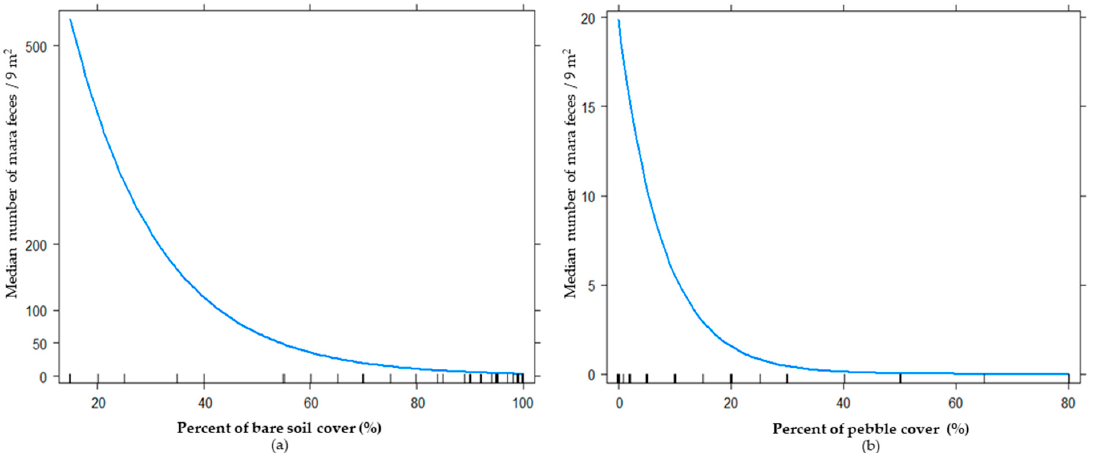
Figure 3. Relationship between habitat use of maras ( Dolichotis patagonum ) measured as median number of mara feces by quadrat (3 m × 3 m) and abiotic variables of models for plant communities and plant strata levels: ( a ) relationship between habitat use of maras and bare soil cover, ( b ) relationship between habitat use of maras and pebble cover.